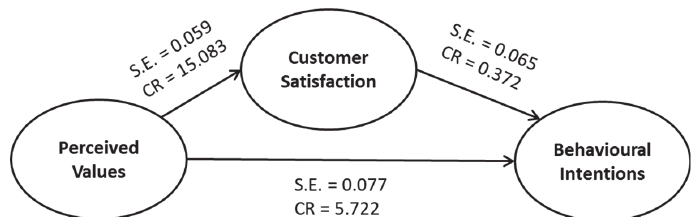
Fig. 3. Mediation of customer satisfaction on relationship between Perceived Value and Behavioral Intentions